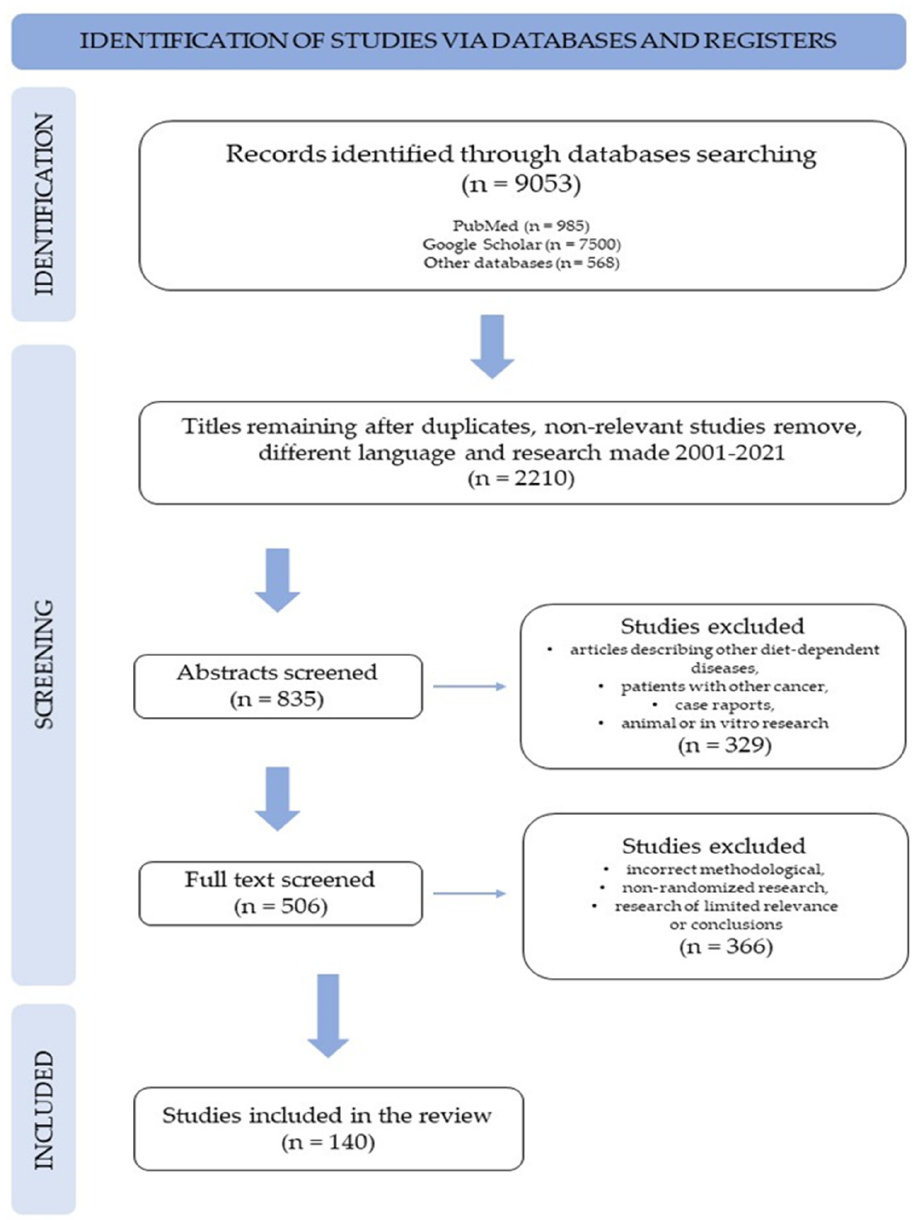
Figure 1. Protocol PRISMA flowcharts for the review.